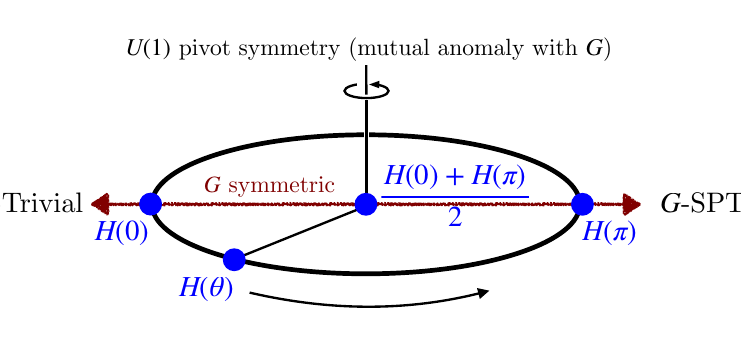
Figure 1: Visualization of the pivot process. By evolving with some pivot